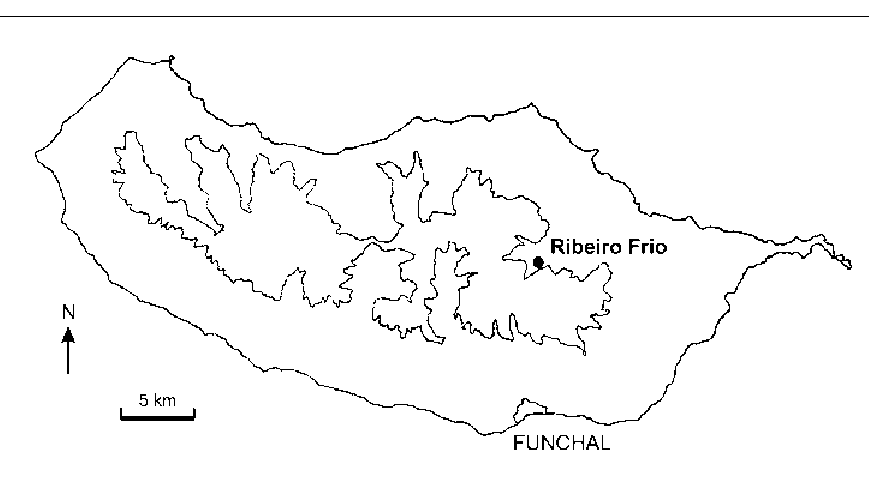
Fig. 1. Sketch map of Madeira. areas above 1000 m altitude within the internal line. adapted from arvidsson and Wall